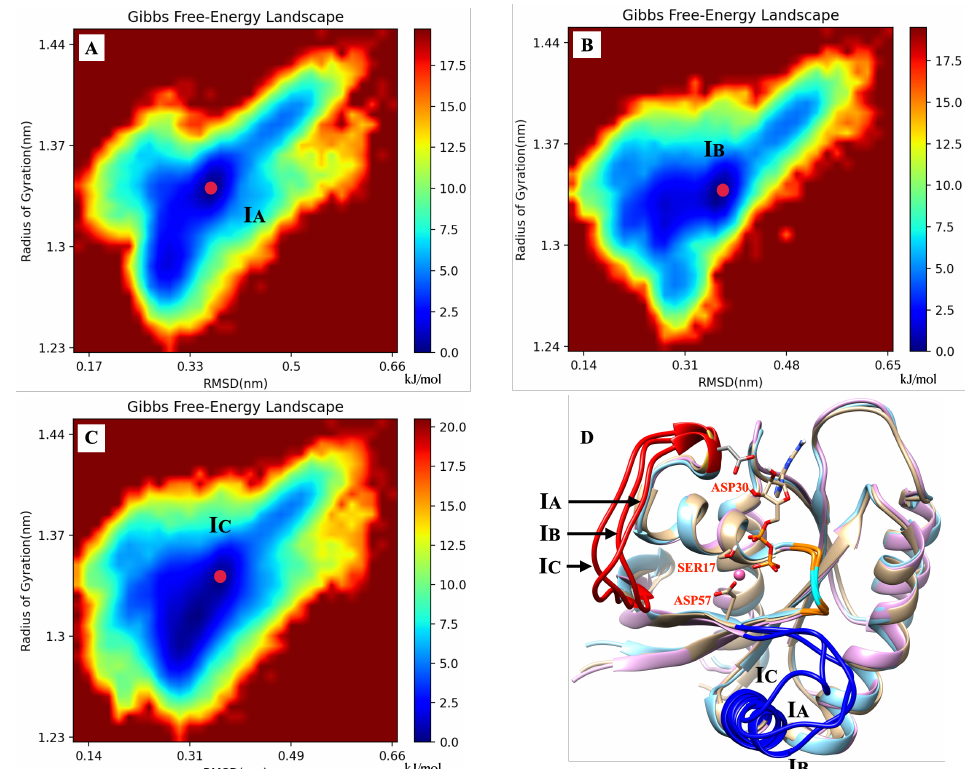
Figure A9. The system including KRAS-G12D reveals that the two generated trajectories of 2.5 µ s produce a very similar free-energy surface (cases A , B ) with the single stable state located approxi- mately at the same coordinates. The average ( C ) is reported in Figure 3 of the manuscript. Stable states indicated by IA, IB and IC. Snapshot ( D ) reveals small differences for the three configurations corresponding to the stable state. Note: here, we choose SW-I, SW-II, GDP and Mg 2 + to calculate RMSD and R g , so the RMSD value here is larger than in Figure A3A. In Figure A3A, the RMSD is calculated for the full KRAS protein.